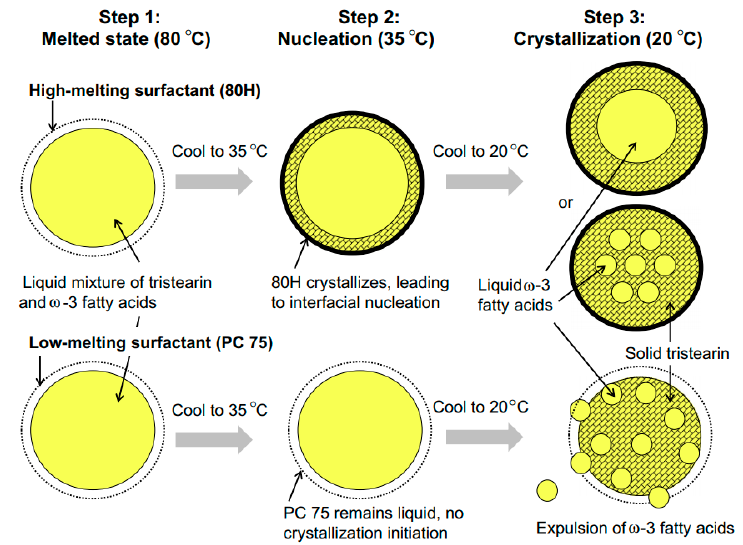
Figure 6. Schematic illustration for the influence of high-melting and low-melting surfactants on the nucleation and crystallization of lipid nanoparticles. Using high-melting lecithin (80H) as the surfactant, core-shell lipid nanoparticles ,with ω -3 PUFAs as the cores, are formed, while, in the case of low-melting lecithin (PC75), a fraction of ω -3 PUFAs might exclude from the crystallized solid lipid matrix upon cooling. (Adapted from [30]).